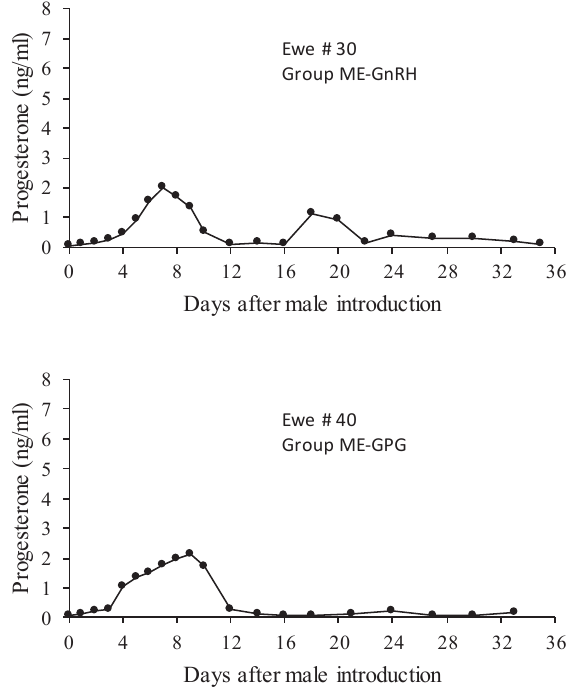
Figure 4. Progesterone profiles of the two ewes that returned to ovarian inactivity after one (top panel) or two (bottom panel) short estrous cycles in experiment